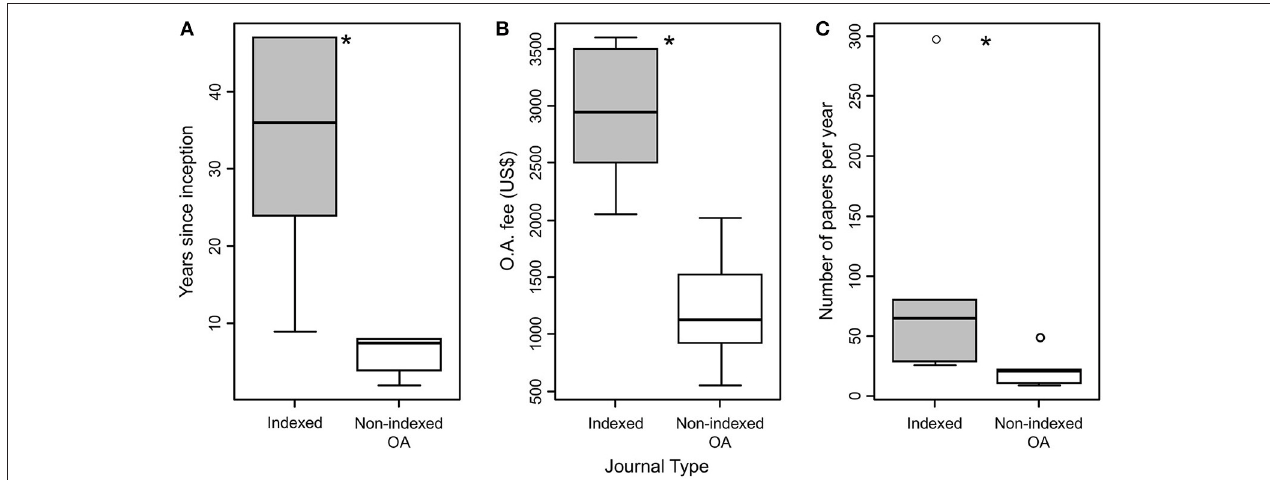
FIGURE 2 | Boxplot representation of journal-level metrics for indexed (gray boxes) and non-indexed OA (white boxes) journals, including the time since the journal was incepted (A) , the cost of publishing open access (A.P.C.) (B) , and the average number of papers published per year (C) . Asterisks denote significant differences between journal types (see Table 2 ). n = 6 per